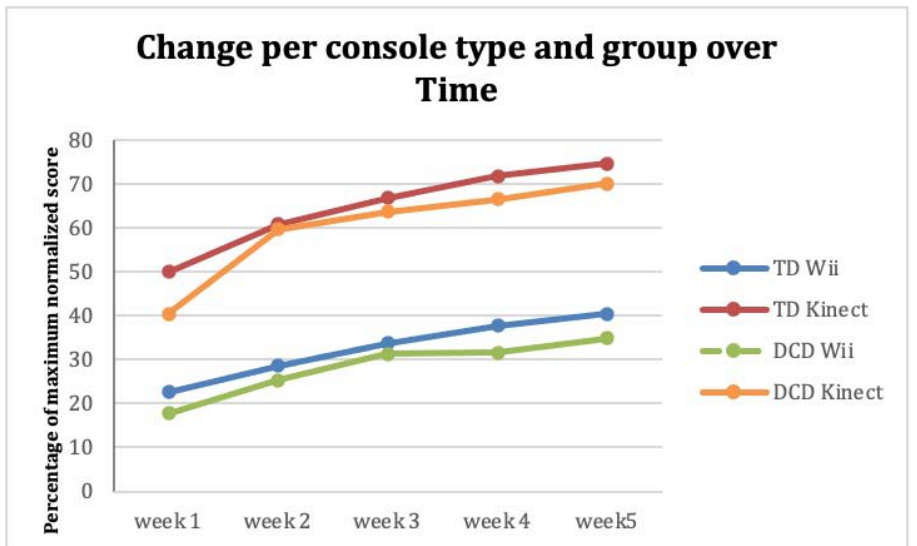
Figure 1. Performance in mean percentage of normalized game scores over five weeks between Wii Fit and Xbox Kinect per participant group.